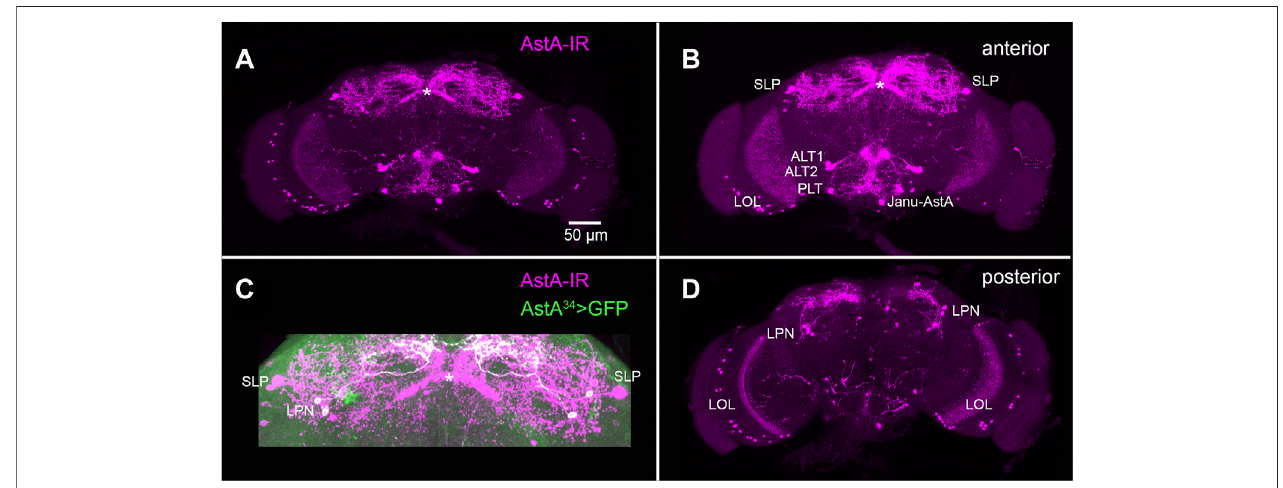
FIGURE3| AstAneuronsintheadultfruit fl ybrain. (A) MaximumprojectionofawholemountadultbrainstainedwithanantiserumagainstDippu-AstA-7[(Vitzthum et al., 1996), magenta]. (B) Stack of the anterior optical sections of the brain in (A) . (C) Superior region of the protocerebrum from (A) , showing additional labelling of AstA 34 > GFPexpression (green)whichmarkstheLPNs.ItisvisiblethattheLPNsdonotinnervatethefan-shapedbodyofthecentralcomplex[asterisk,(Reinhardetal., 2022)]. (D) Stack of the posterior optical sections of the brain in (A) . Original preparations. Scale bar = 50 µm is identical for (A – D)